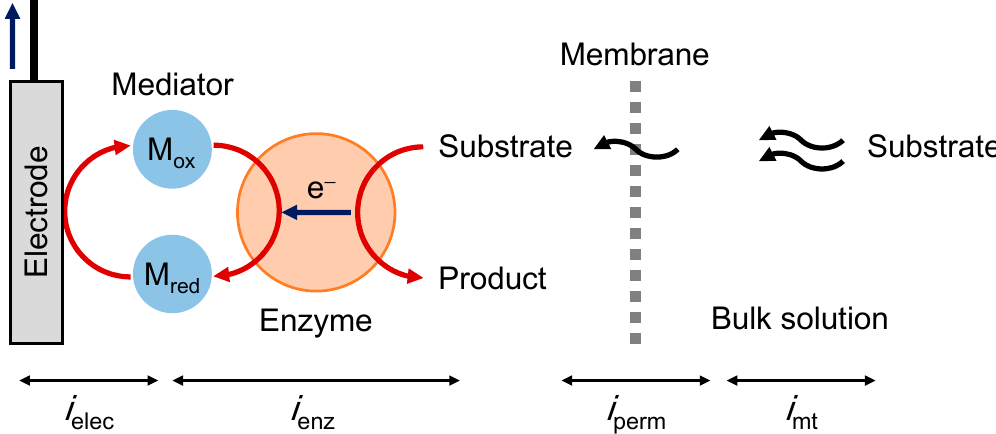
Figure 1. Schematic view of mediated electron transfer (MET)-type bioelectrocatalysis based on a serial resistance model.